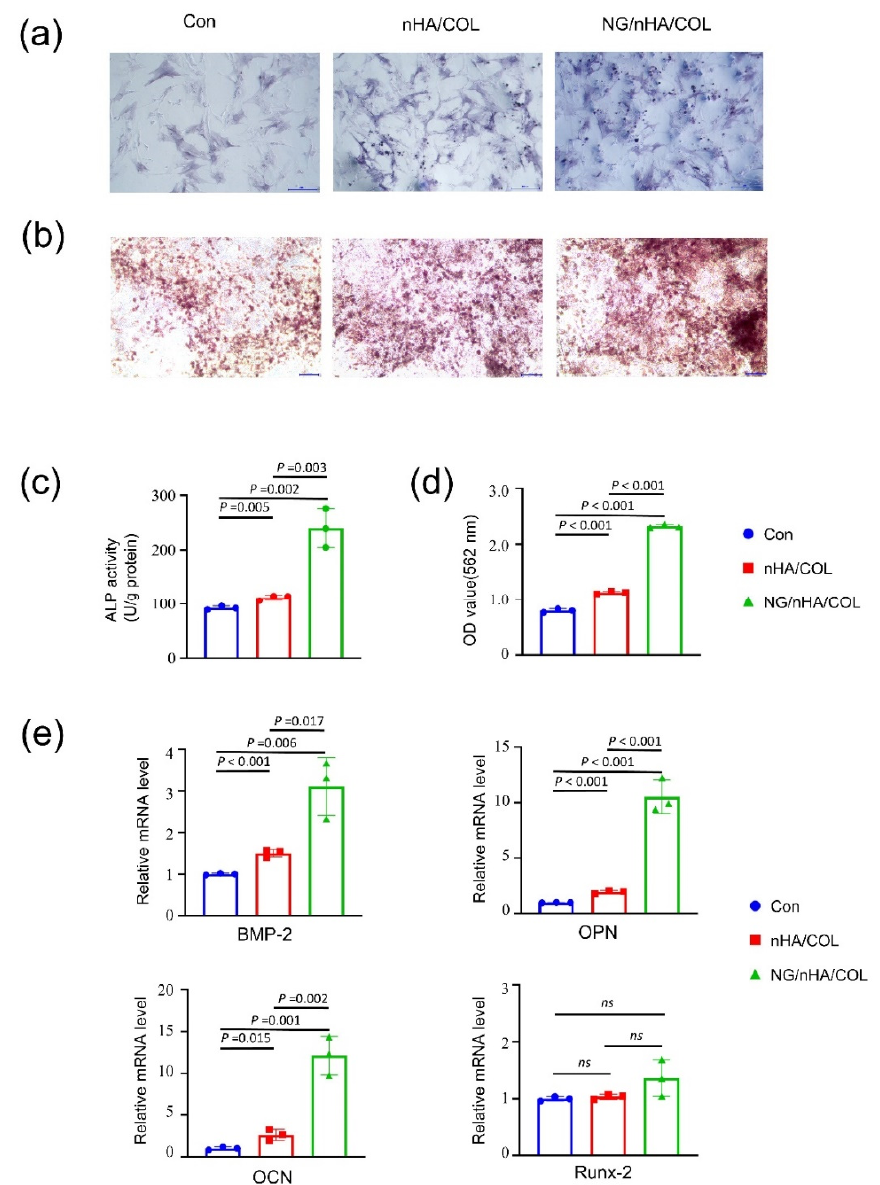
Figure 5. In vitro osteogenesis properties of NG/nHA/COL. BMSCs were cultured using nHA/COL and NG/nHA/COL culture media extracts. ( a ) ALP staining images of control, nHA/COL, and NG/nHA/COL groups after 7 d of osteogenic induction (scale bar: 200 µ m). ( b ) ARS staining images of control, nHA/COL, and NG/nHA/COL groups after 21 d of osteogenic induction (scale bar: 100 µ m). ( c ) ALP activity of three groups (n = 3). ( d ) Quantitative results of ARS staining of three groups (n = 3). ( e ) The osteogenic ‐ related genes expression, including BMP ‐ 2, OPN, OCN, and Runx ‐ 2 (n = 3).